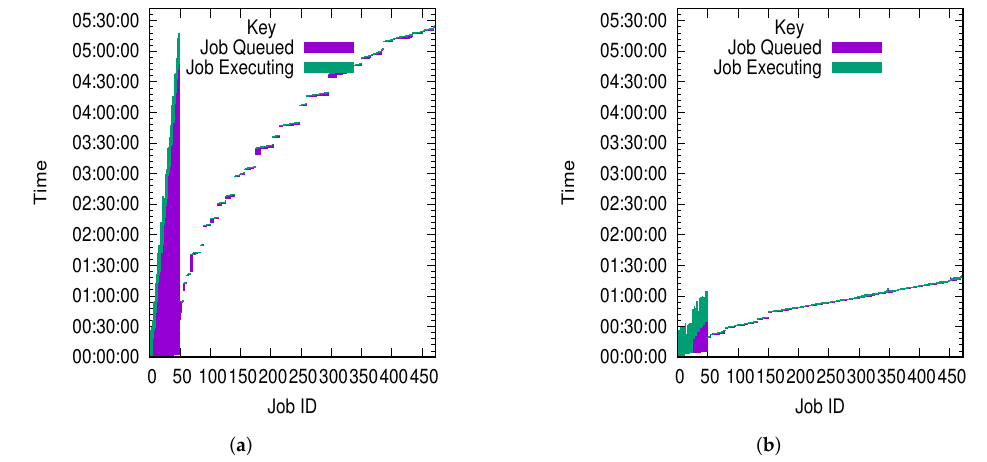
Figure 5. Execution of a 1.0 degree workflow on a 1 node vs. 6 node cluster: ( a ) 1.0 degree Montage on a small cluster; ( b ) 1.0 degree Montage on a large cluster.